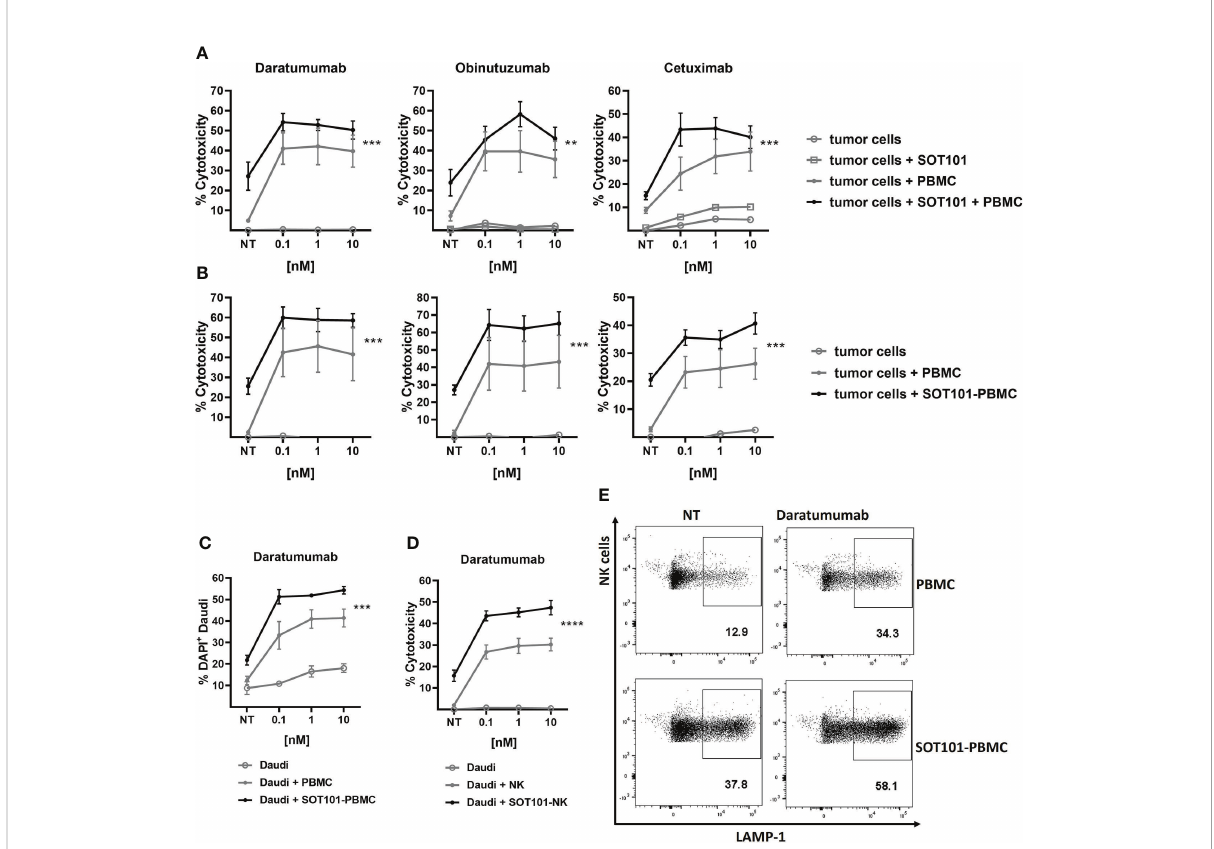
FIGURE 3 SOT101 enhances the tumor cell killing activity of therapeutic antibodies in vitro (A) Concomitant treatment: PBMCs were added to the target tumor cells together with SOT101 at 1 nM and the therapeutic antibodies at 0.1, 1 and 10 nM and incubated for 20 h E:T ratio was 25:1 for Daudi (Daratumumab, Obinutuzumab) and 150:1 for SCC25 (Cetuximab) cells, respectively. (B) Sequential treatment: PBMCs were fi rst pre-stimulated with 0.1 nM SOT101 for 3 days (SOT101-PBMC) and then added to the target tumor cells together with therapeutic antibodies at 0.1, 1 and 10 nM and incubated for 24 h E:T ratio was 15:1 for Daudi and 100:1 for SCC25 cells, respectively. The percentage of cytotoxicity was determined by a LDH release assay. (C, E) PBMCs were pretreated with SOT101 (0.1 nM, 3 days) and then incubated with Daratumumab and Daudi cells (E:T 1:1) for 4 h (C) The percentage of dead DiD + DAPI + tumor cells was determined by fl ow cytometry. (E) Representative dotplots for NK cell degranulation as determined by CD3 - CD56 + LAMP-1 + staining Daratumumab was used at 0.1 nM here. (D) Isolated NK cells were pretreated with SOT101 (0.1 nM, 2 days) and then incubated with Daratumumab (0.1, 1 and 10 nM) and Daudi tumor cells (E:T 10:1) for 4 h. The percentage of cytotoxicity was determined by a LDH release assay. Data represent mean ± SEM from 3-6 healthy donors. The results were considered statistically signi fi cant if ** p < 0.0021, *** p < 0.0002 or **** p <